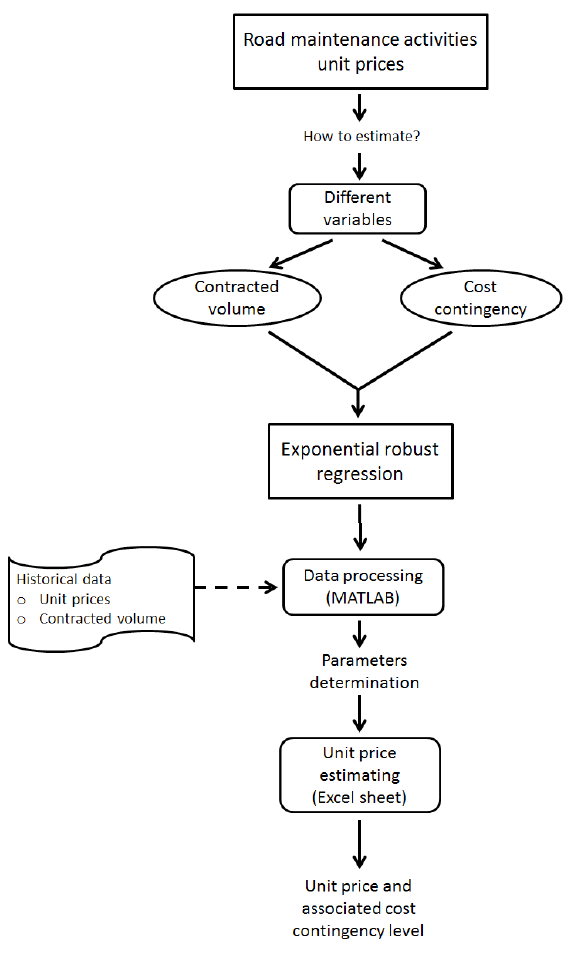
Fig. 1. Flowchart of the